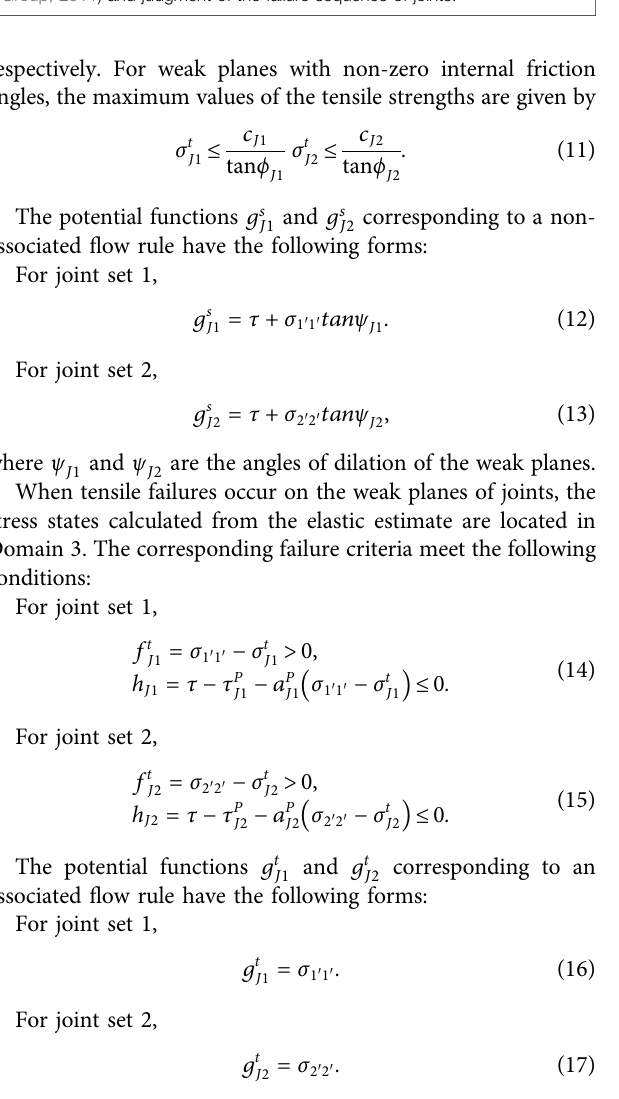
FIGURE3| FailurecriterioninM – Cconstitutivemodel(ItascaConsulting Group, 2011) and judgment of the failure sequence of joints.